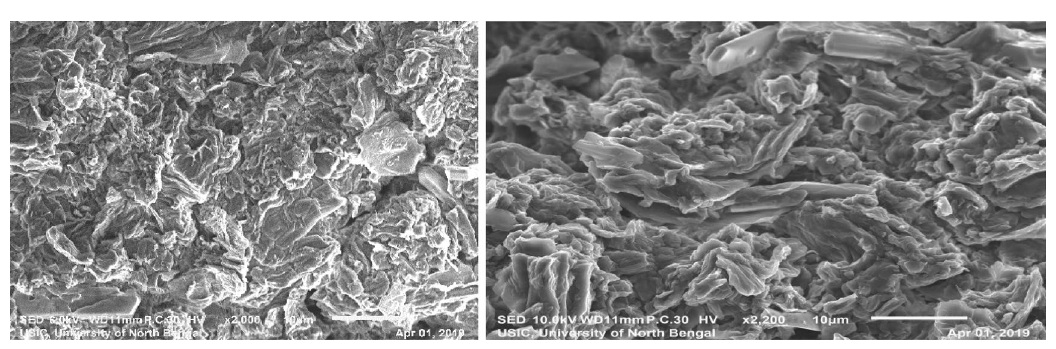
Figure 2. SEM images of GO and GO after 5th